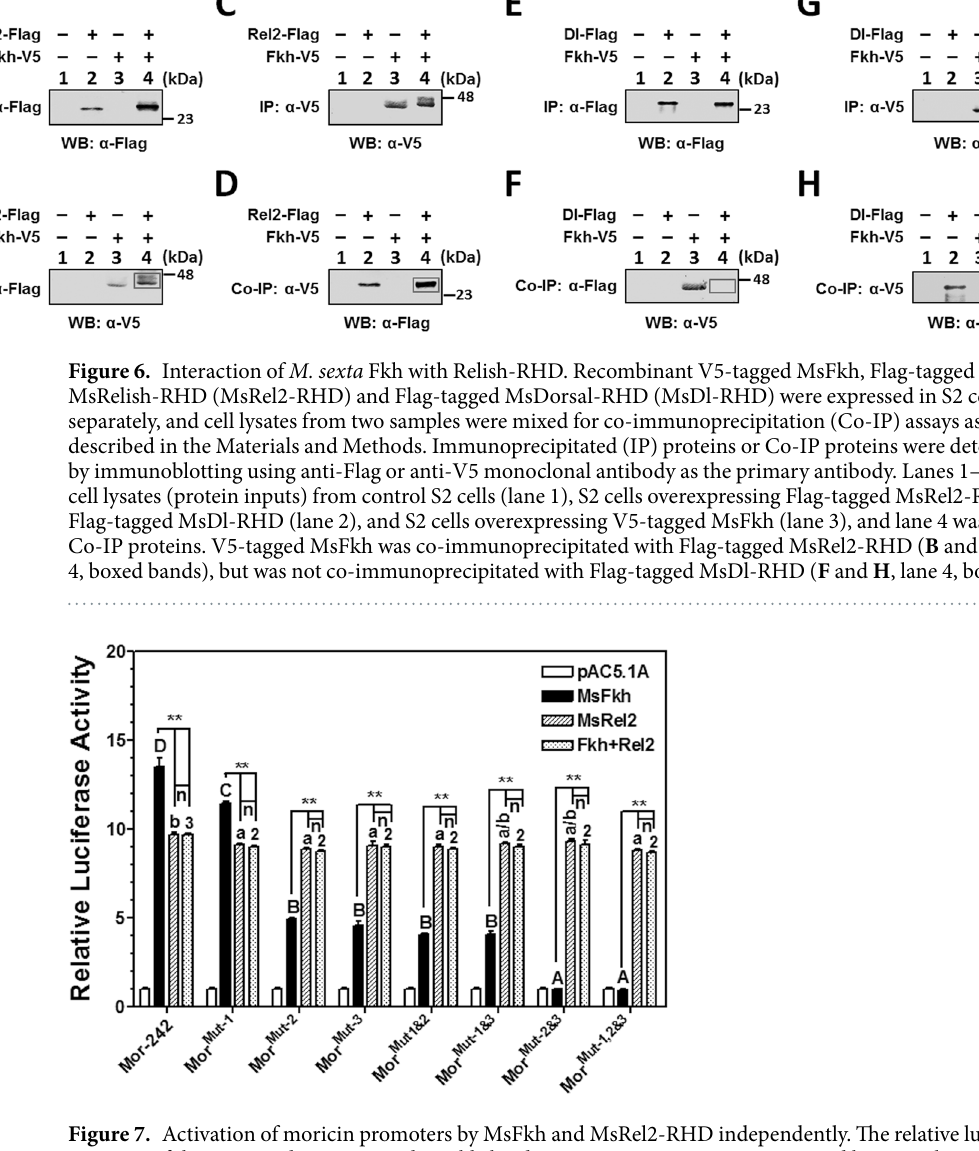
used Mor-242 and its seven Fkh mutant promoters (Fig. 5A) for the dual luciferase assays. For MsFkh-stimulated activity (Fig. 7, solid bars), mutations of individual Fkh-binding sites alone (site 1, 2 or 3) or combination of Fkh-binding sites (sites 1 and 2, 1 and 3, 2 and 3, or all three sites) significantly decreased the activity of Fkh mutant promoters, a result similar to that in Fig. 5C, indicating that Fkh-binding sites indeed play a role in activation of moricin promoter by Fkh factor. Co-expression of MsFkh and MsRel2-RHD had similar effect as overexpression of MsRel2-RHD alone (Fig. 7, comparing stripe bars and dotted bars across different promoters, as well as between the stripe and dotted bars in each promoter), suggesting that presence/absence of MsFkh and Fkh-binding sites does not have an impact on activation of moricin promoter by MsRel2-RHD, and the over- all activity of these moricin promoters is due to MsRel2-RHD binding to NF- κ B site in the moricin promoter.